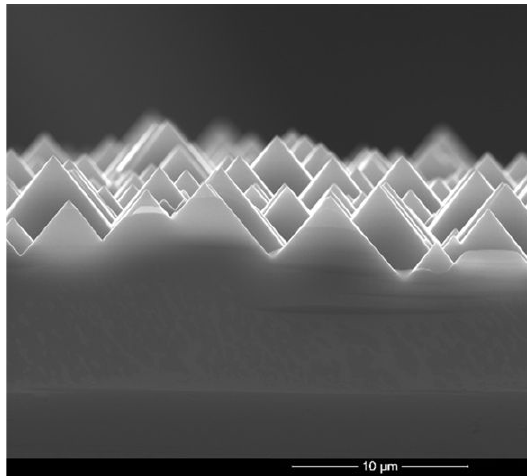
Figure 3. Cross-sectional MEV image of the textured silicon wafer. The pyramid heights vary from 5-8 µm.